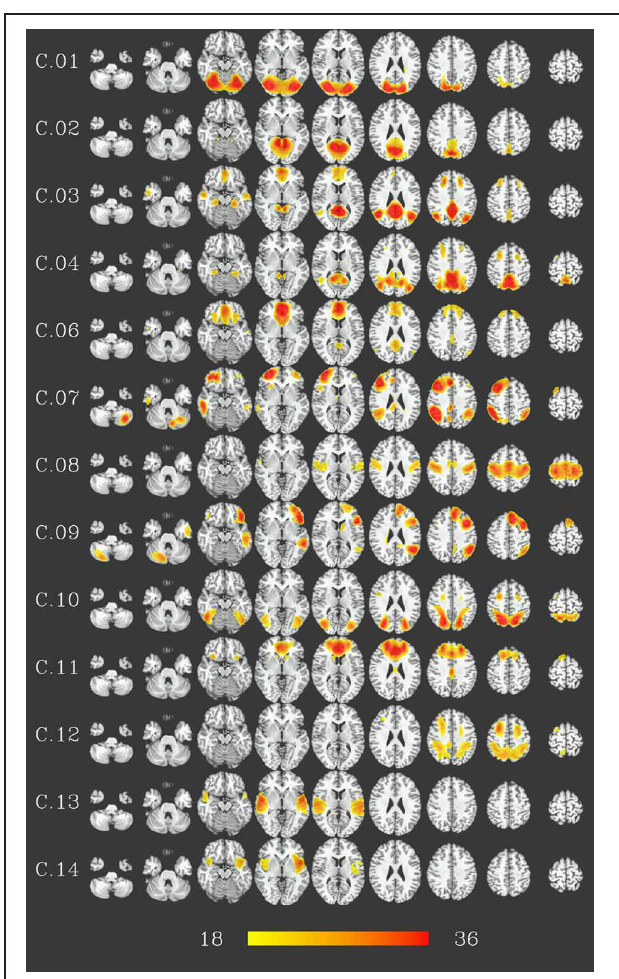
FIGURE 2 | Consistent gray-matter networks from 1000 resting-state datasets. Results are presented as t -values, thresholded at t 999 = 18 ( p = 1 . 6 · 10 − 57 , FWE-corrected), each row corresponding to one network showing nine representative slices spaced 15mm in z direction. Red color represents highest t -values, images are shown in radiological convention (the right side of the brain is displayed on the left). Color bar shown for t -values between 18 and 36 (bottom).